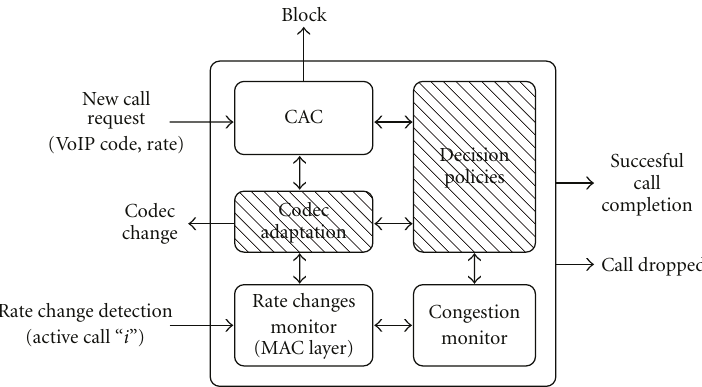
Figure 1: General codec adaptation